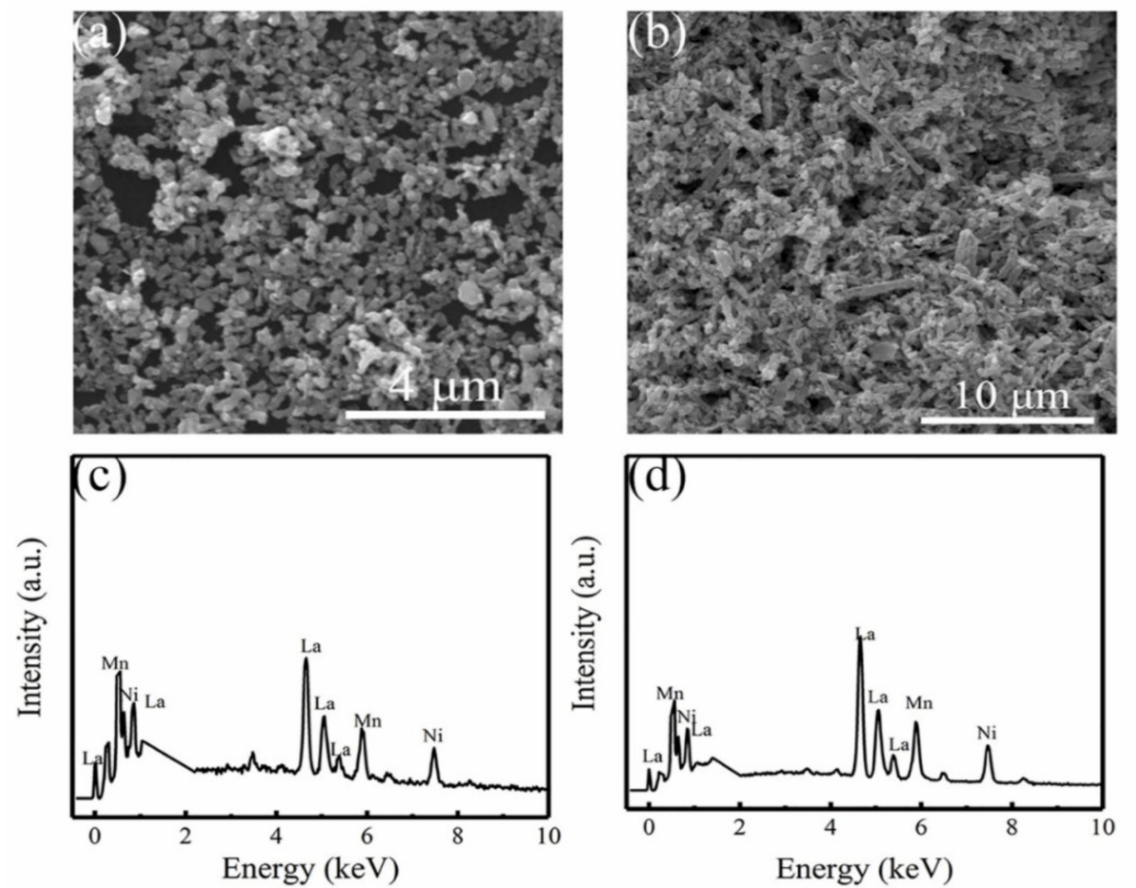
Figure 2. SEM images of the as-synthesized LNMO samples. ( a ) LNMO NPs and ( b ) LNMO NRs. EDS spectra of the as-synthesized ( c ) LNMO NPs and ( d ) LNMO